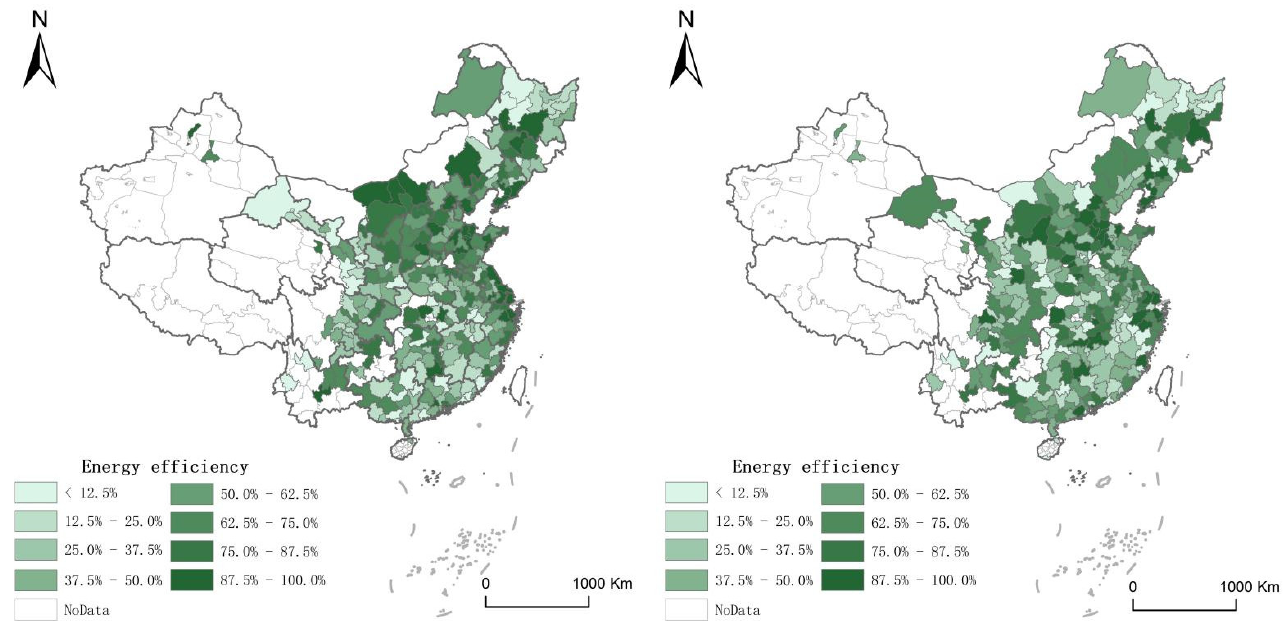
Figure 1. The distribution of the energy efficiency of China in 2009 and 2018. (3) Threshold variables (spatial integration, Spa ): the existing literature does